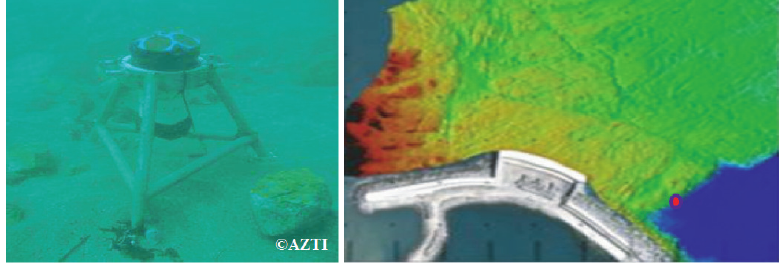
Figure 9. Acoustic doppler current profiler in